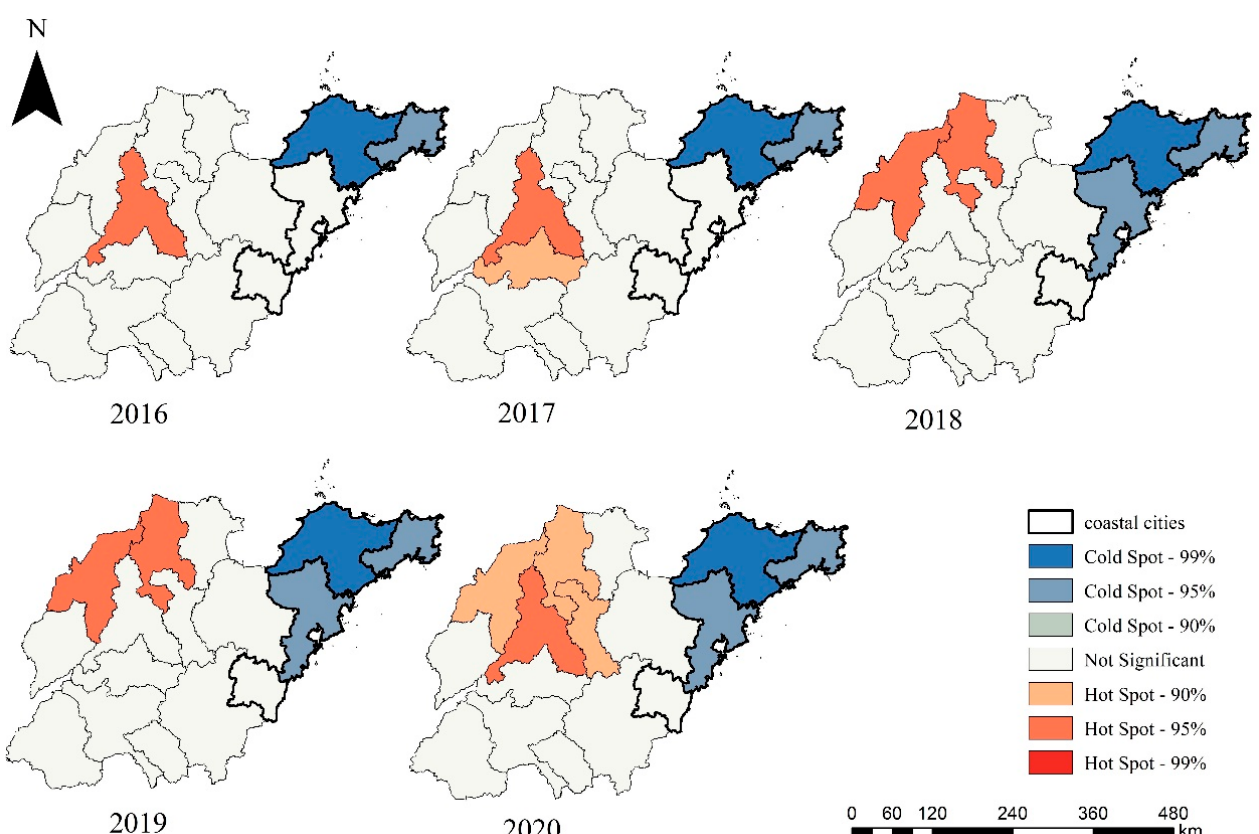
Figure 4. Hot spot analysis results of annual O 3 concentrations from 2016 to 2020. Red is the high-value cluster area of O 3 , and blue is the low-value cluster area of O 3 .